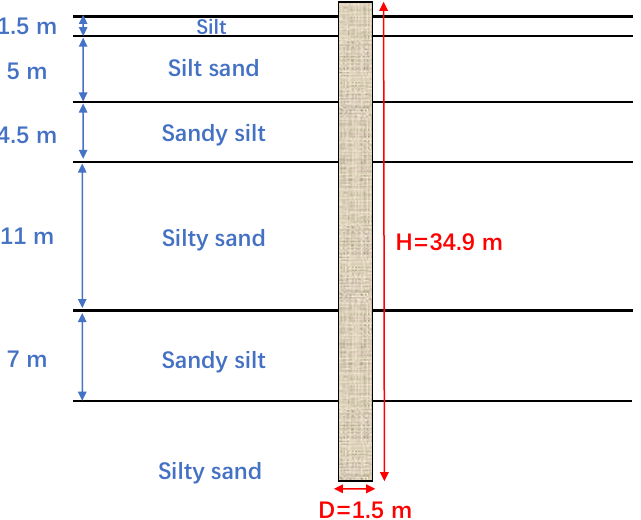
Figure 3. A diagrammatic sketch of a soil foundation model for the numerical simulation in the present study [25,27]. Table 1. The physical parameters of soil properties [25,27].